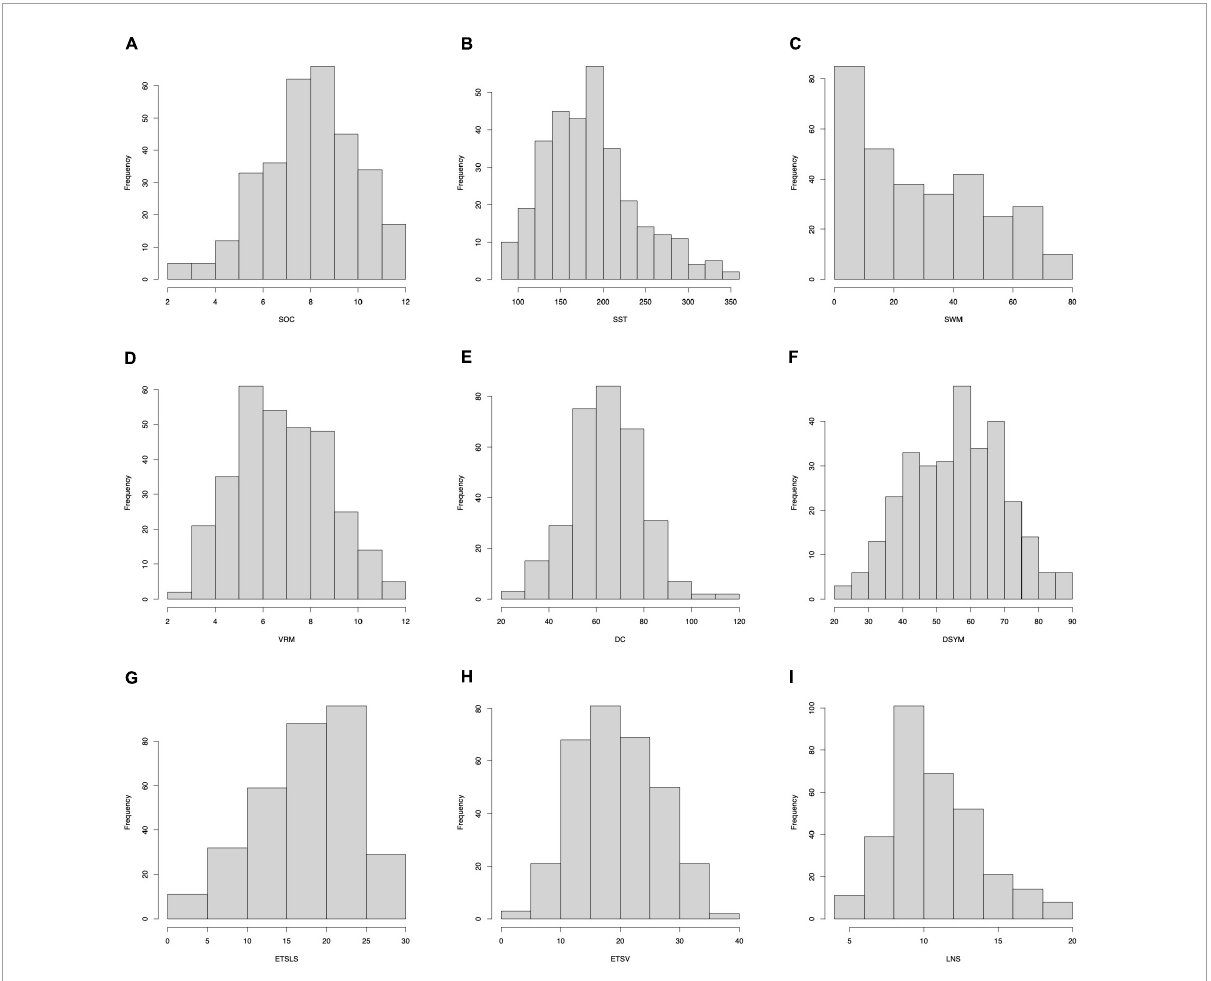
FIGURE8 Distributions of cognitive scores. (A–I) Denote the nine cognitive